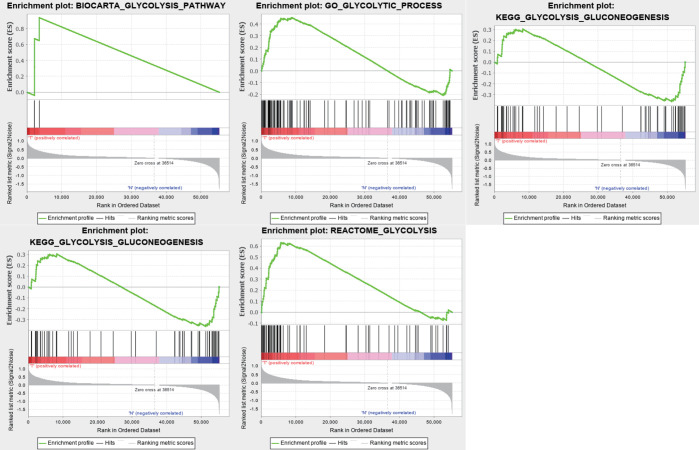
Enrichment plots of five gene sets which had significant difference between normal tissues and BC tissues by performing GSEA.